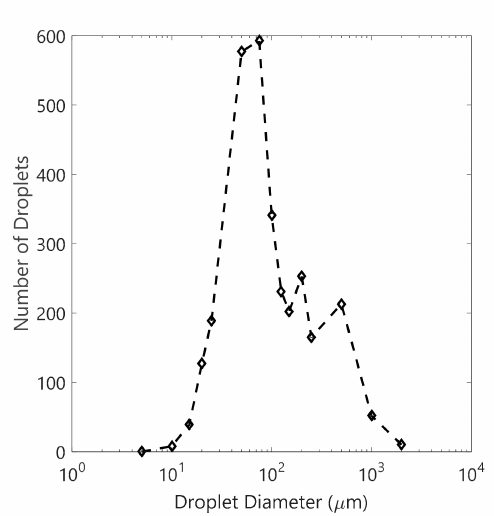
Figure 2. The droplet distribution according to the data in